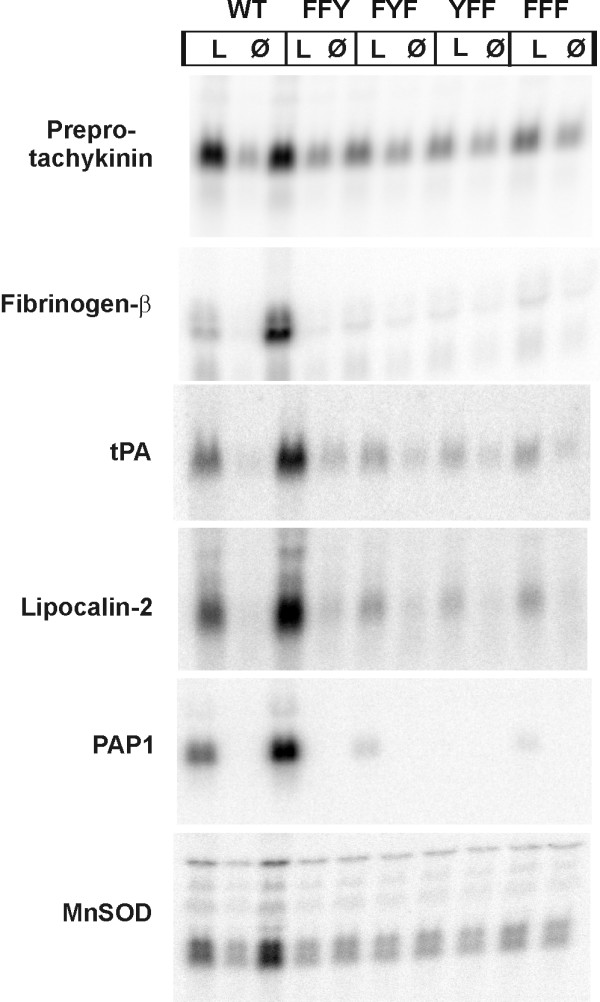
Regulation of leptin target gene expression by LEPRb tyrosine mutants. RINm5F cells expressing the indicated LEPRb tyrosine mutants were treated with 100 ng/ml leptin (L) or vehicle (∅) for 16 h. Northern blots were hybridised with the indicated cDNA probes.